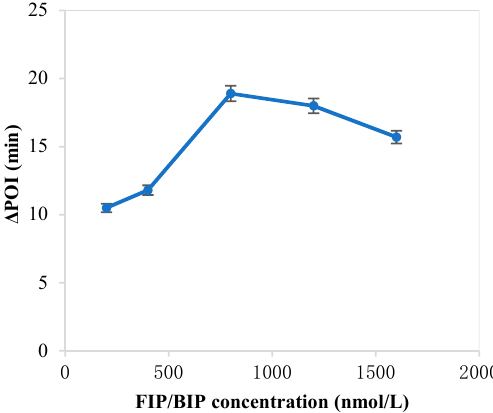
Figure 2. The optimization of the concentration of FIP/BIP on the RC-LAMP assay. The graph shows the Δ POI value vs. the concentration of FIP/BIP. Experimental conditions: padlock probe 20 pmol/L, miR-200a 1 pmol/L, T4 DNA ligase 70 U and amplification temperature 62 °C, respectively.